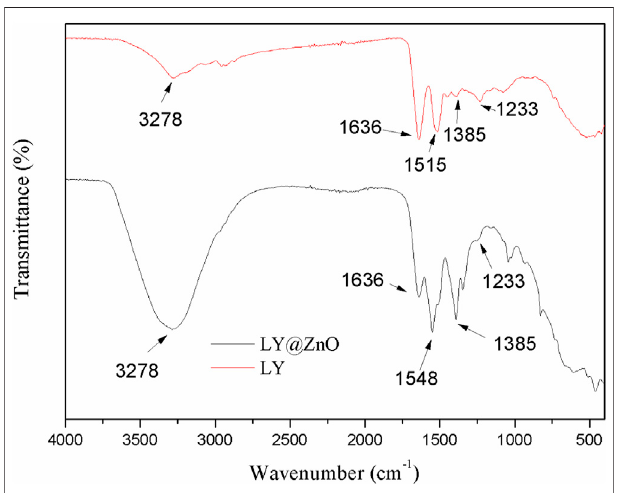
FIGURE 4 | FTIR spectra of (A) LY and (B) LY@ZnO.